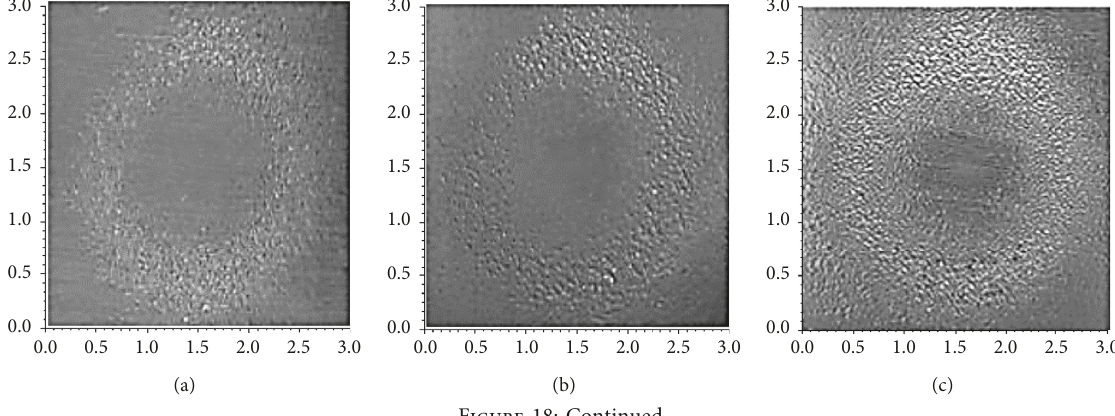
6.69, Q (cid:31) 8.1m 3 /h. (f) Area (cid:31)